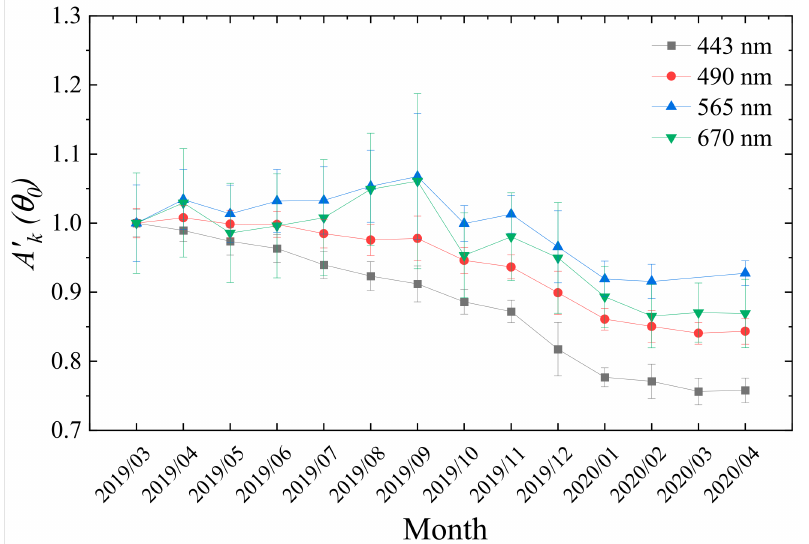
) from March 2019 to April 2020 for ( θ 0 k